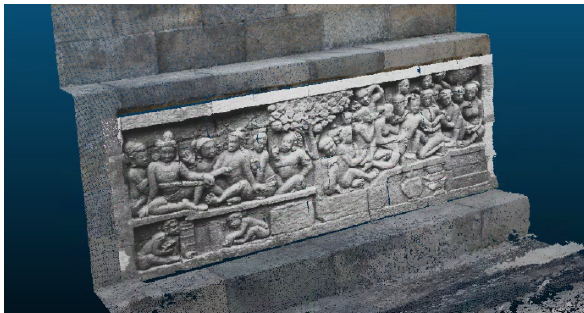
clouds. Based on different density of the point clouds, the opa- city α was set to 0.8 for the photogrammetry scanning data and 0.2 for the reconstructed point cloud. The fused